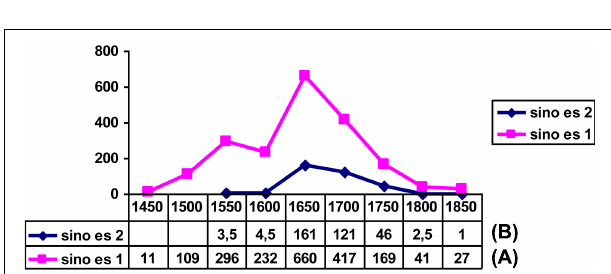
FIGURE 7 | Evolution of weighted frequencies for sino es “if not, but”: (A) with an exceptive meaning ( sino es 1: no se casan sino es con permiso , “they won’t marry but with permission,” and (B) with corrective adversative meaning ( sino es 2: no son pobres sino es ricos , “they are not poor but rich”). Data from